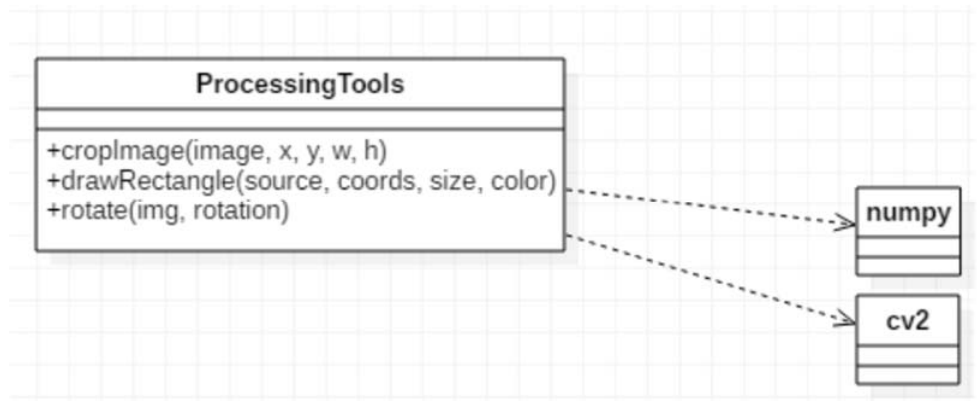
Figure 16. Class diagram of the Processing Tools module.